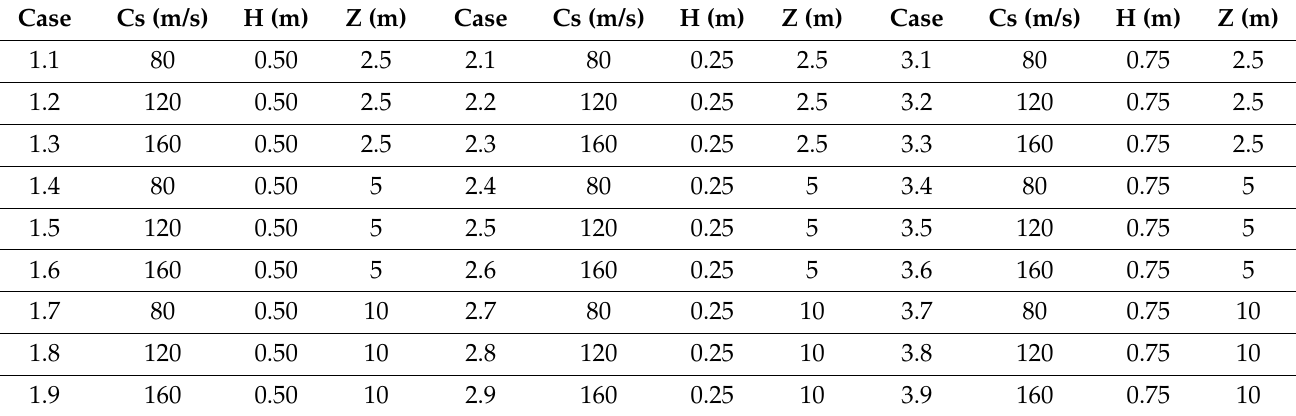
Table 2. Scenarios under analysis.